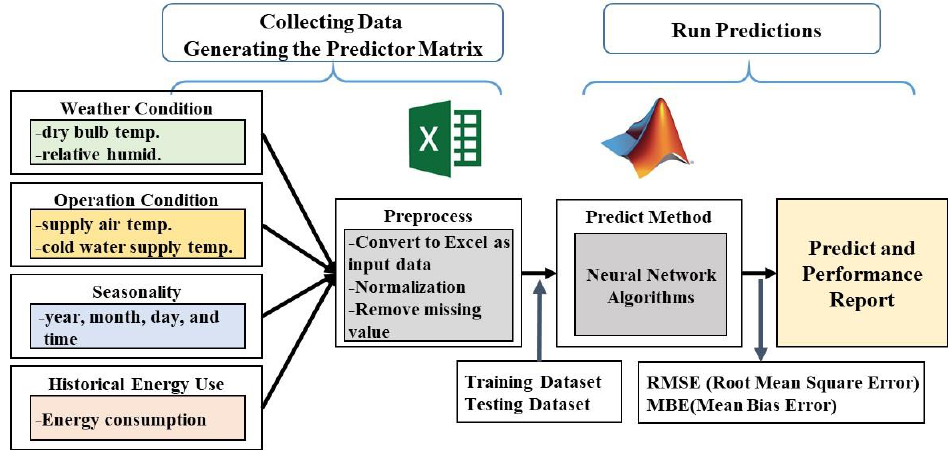
Figure 1. Schematic diagram of the process of predicting energy consumption of the absorption heat pump. heat